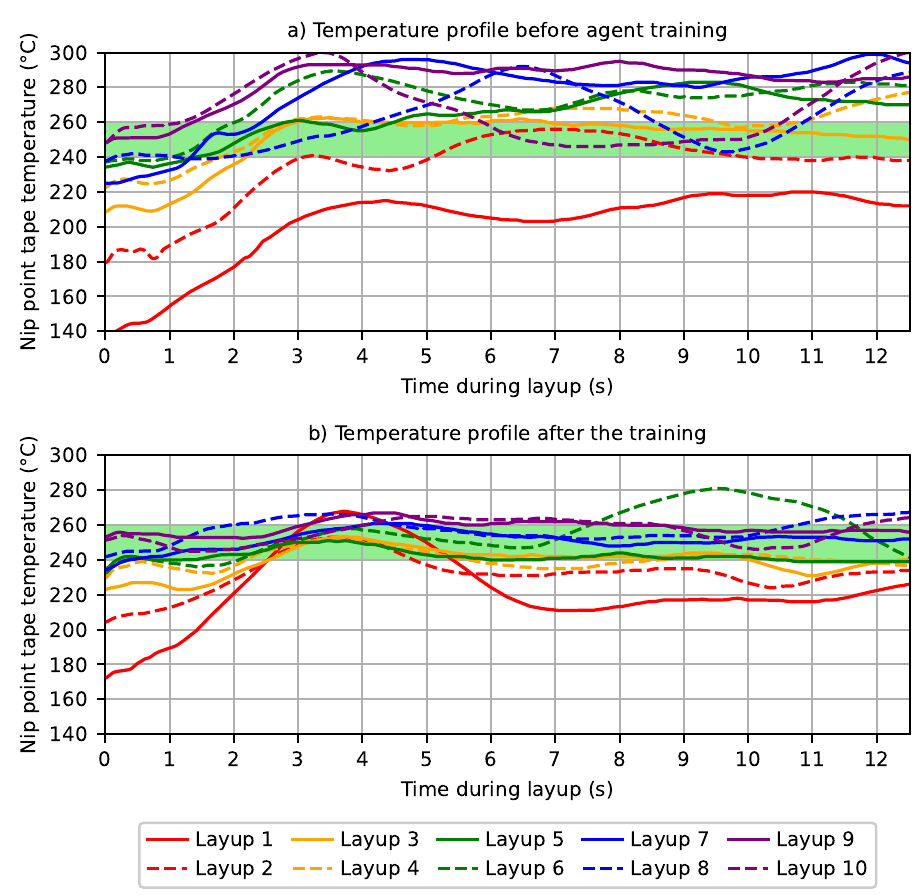
Figure A1. Comparison of the Temperature at the Nip Point with Untrained and Trained